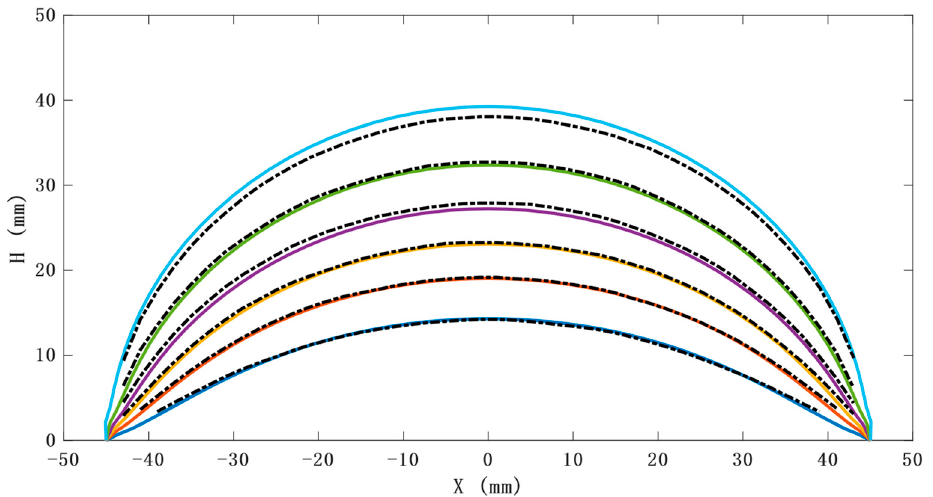
Figure 17. FEA and actual contour of the CTPM under different various air pressure values. The solid line represents the results of FEA based on ABAQUS, and the dotted line represents the actual measurement results.